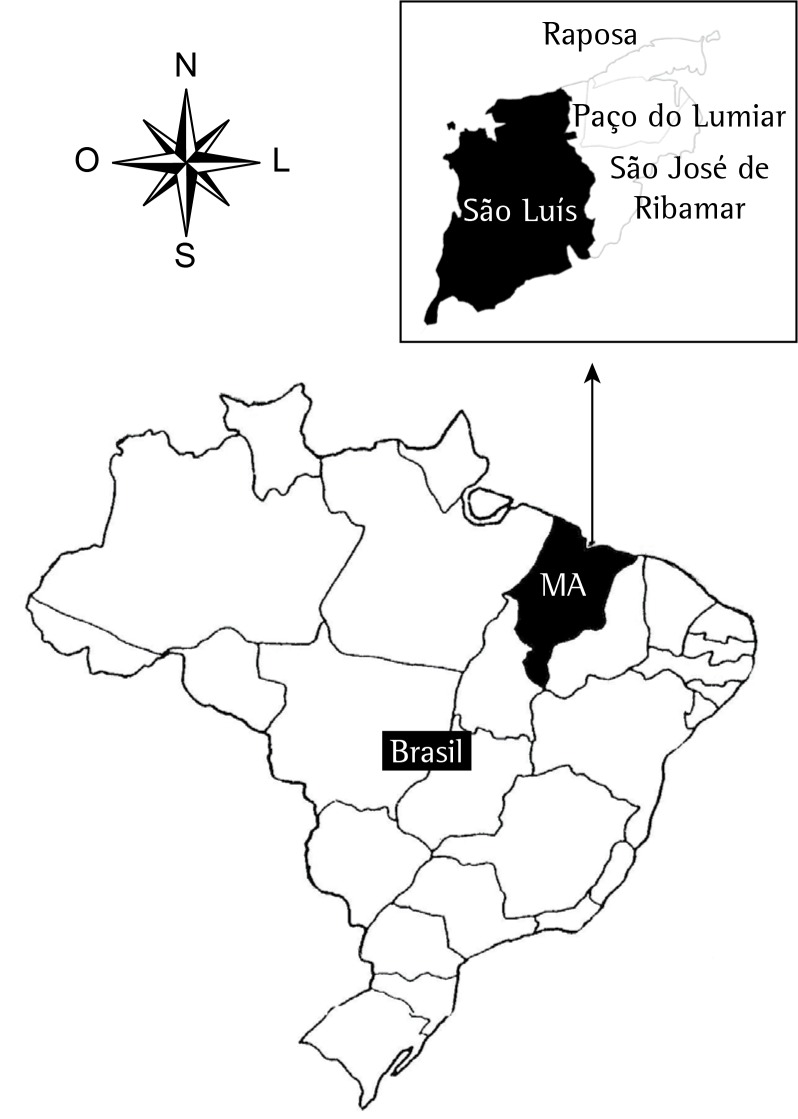
Mapa do Brasil com destaque para a cidade de São Luís, estado do
Maranhão (MA). Adaptado de bases geográficas, Instituto Brasileiro de
Geografia e Estatística.(8